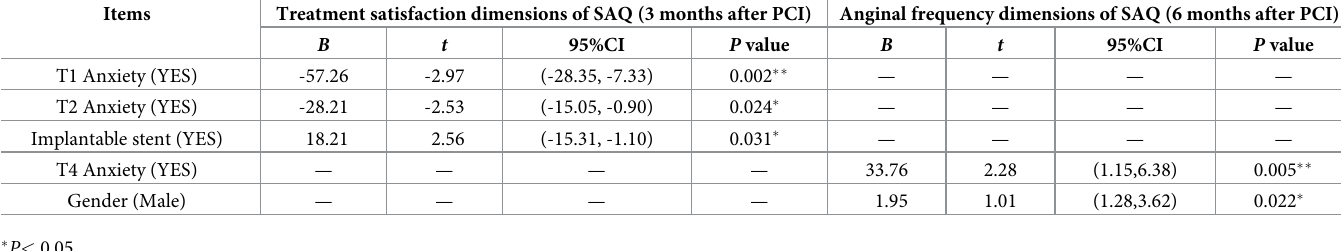
Table 5. Multivariate linear regression analysis of influencing factors on the treatment satisfaction dimensions of SAQ at 3 months and on the Anginal frequency dimensions of SAQ at 6 months after PCI. Items Treatment satisfaction dimensions of SAQ (3 months after PCI)